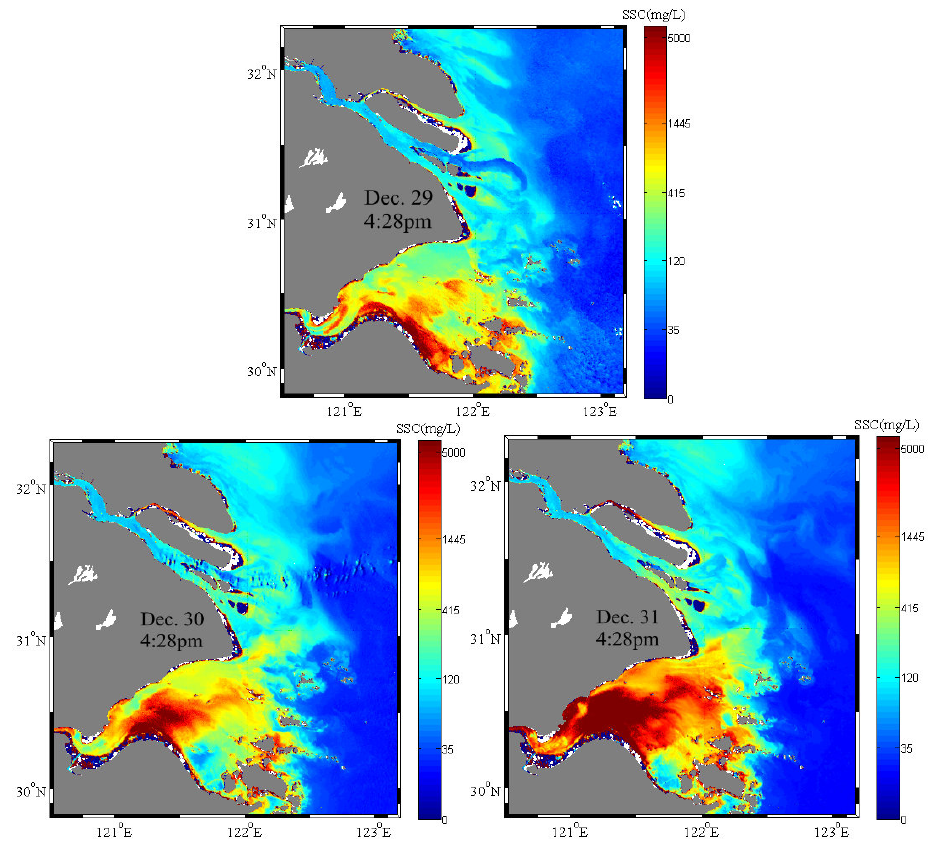
Figure 3. Surface SSC (mg/L) in the study area derived from GOCI satellite data at 4:28 p . m . , 29 December 2013 for model initialization and at 4:28 p . m . , 30 and 31 December 2013 for model validation.